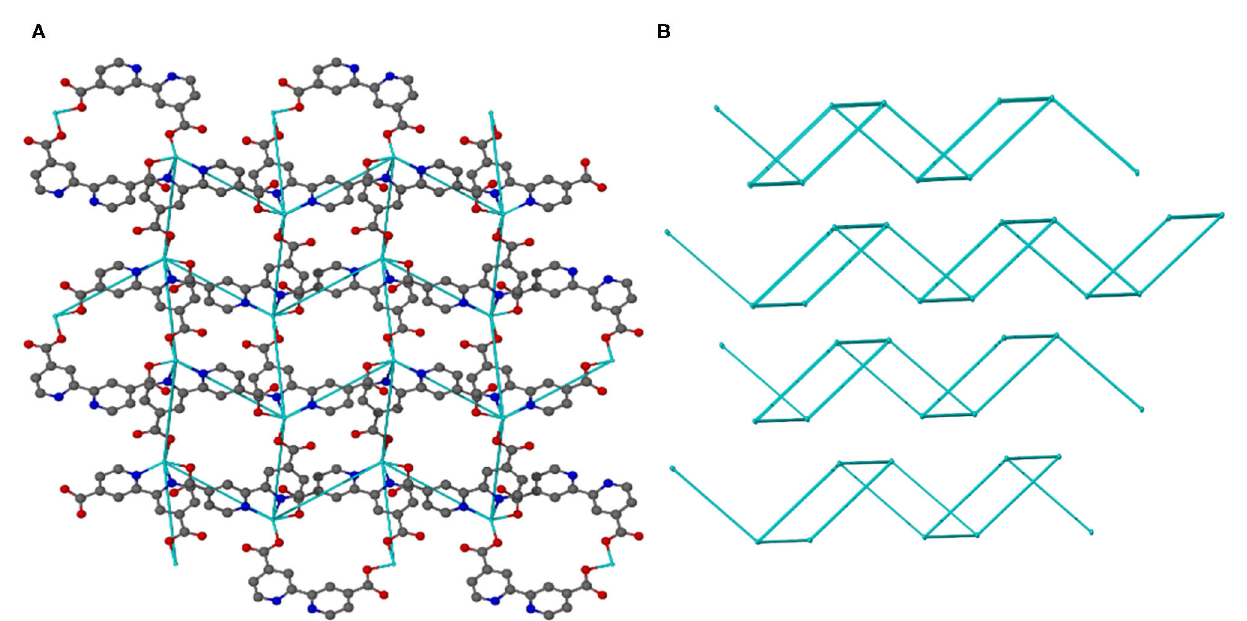
Frontiers in Chemistry |